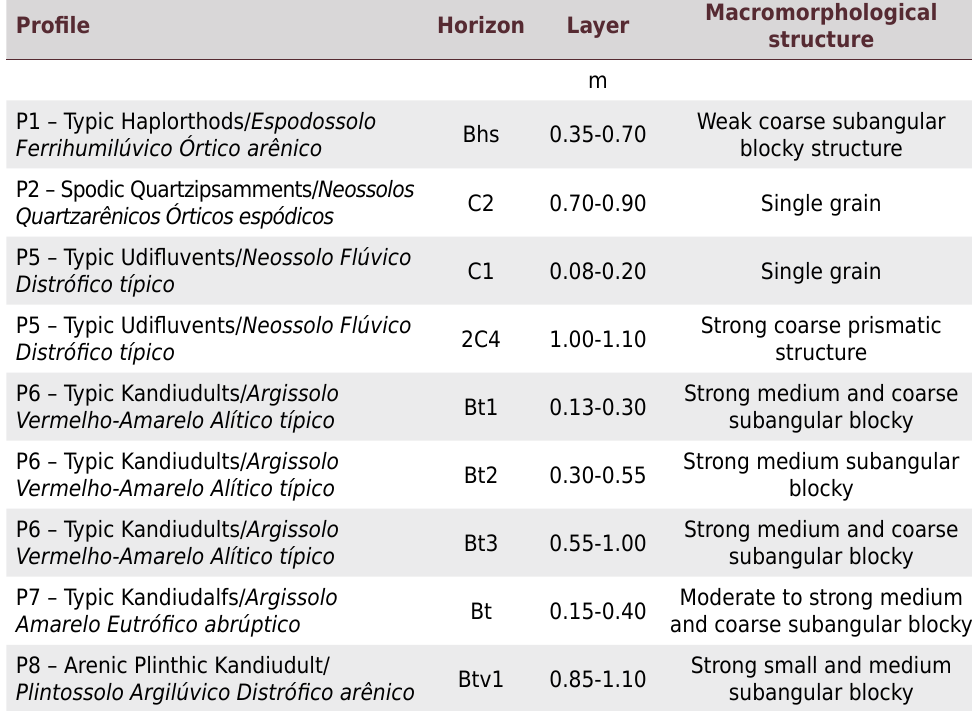
Table 2. Thin sections of the diagnostic horizon of P1, P2, P5, P6, P7, and P8 investigated on the electronic microscope and submitted to qualitative EDS